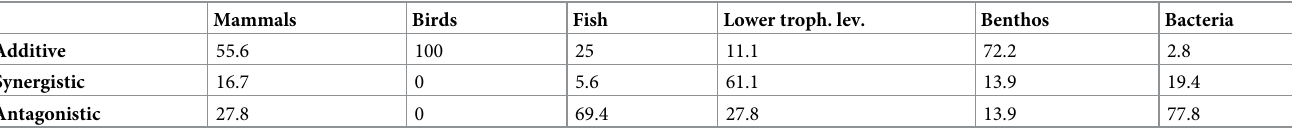
Table 5. Additive/Non-additive effects on component groups (in % of runs). All 36 combination runs were considered.